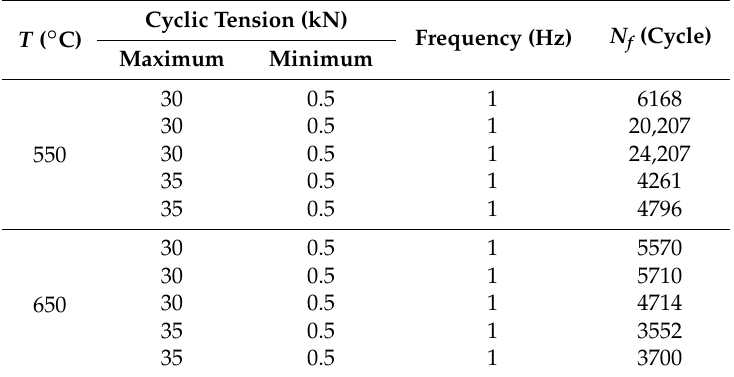
Table 4. Experimental results of the fatigue life of the pre-tightened bolt (M8 × 1).